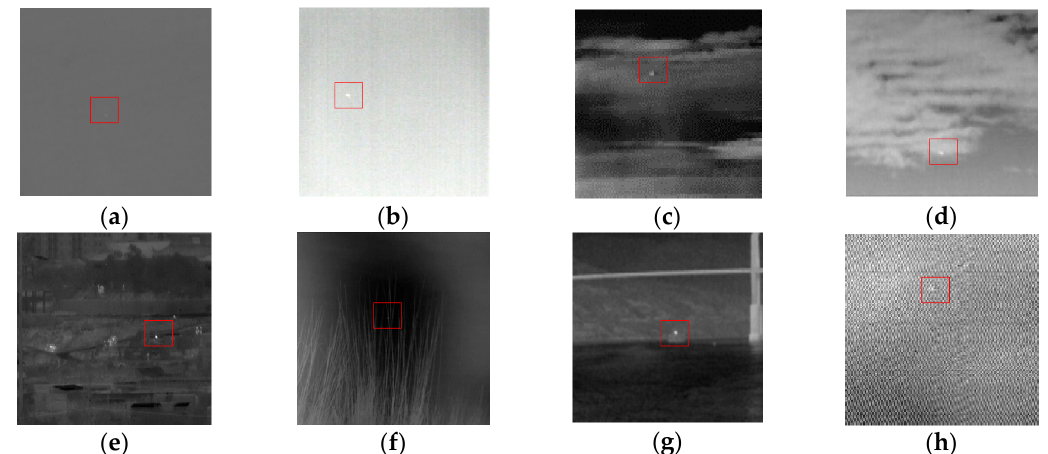
Figure 4. The eight real scenes used in the experiments. For the sake of visualization, all the images are changed to the same size. ( a ) Scene 1 (Sequence 1); ( b ) Scene 2 (Sequence 2); ( c ) Scene 3 (Sequence 3); ( d ) Scene 4 (Sequence 4); ( e ) Scene 5 (Sequence 5); ( f ) Scene 6 (Sequence 6); ( g ) Scene 7; ( h ) Scene 8. Table 2. Detailed description of the eight real scenes.